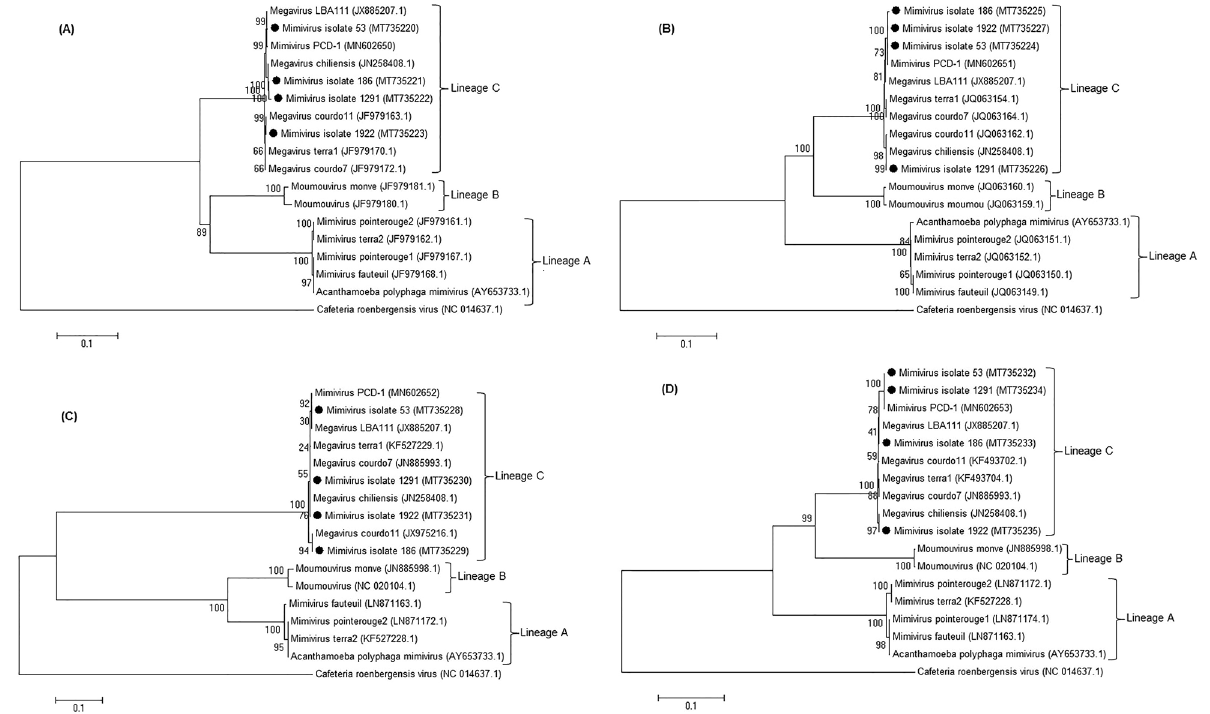
Figure 2. Neighbor-joining tree constructed based on nucleotide acid sequences of the family B DNA polymerase ( A ), the D5-ATPase-helicase ( B ), the major capsid protein ( C ), and the VV A18 helicase ( D ) genes. Outgroup was Cafeteria roenbergensis virus. Our isolated Mimiviruses are present within the Mimivirus C